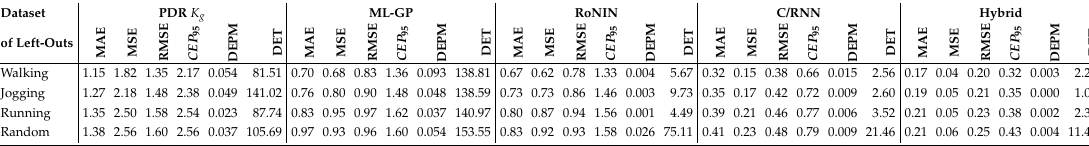
Table 5. Accuracy; left-outs; velocity errors in m/s, distance errors in